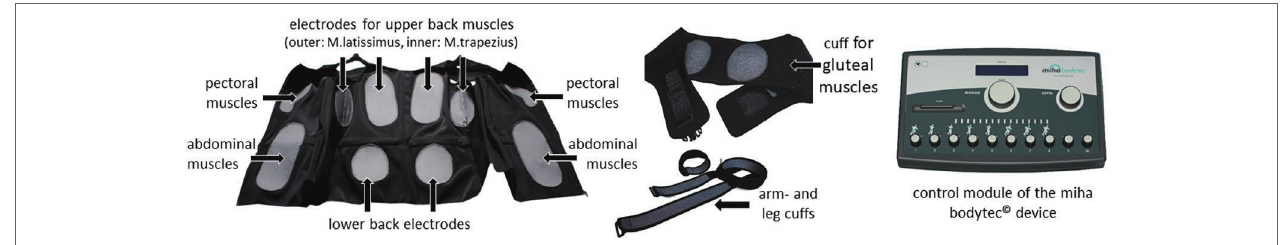
FIGURE 1 | miha bodytec© WB-EMS equipment; from left to right: vest; cuffs for glute, arm, and legs; control device (Permissions were obtained from the copyright holders of the miha bodytec © product for the use for research purposes).